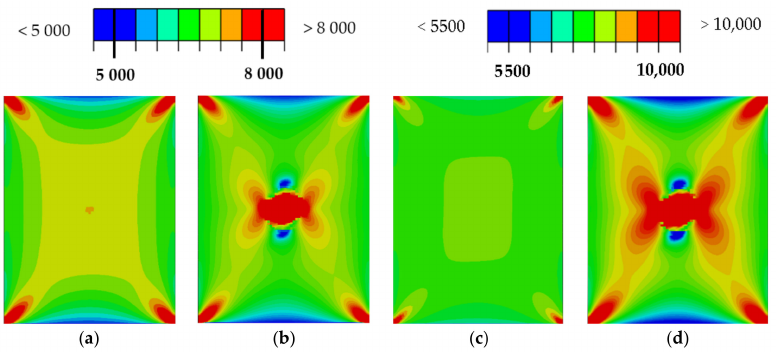
Figure 19. Max. principal strain distribution ( µ m/m); Pristine 80 kN ( a ); Damaged (10 J) 80 kN